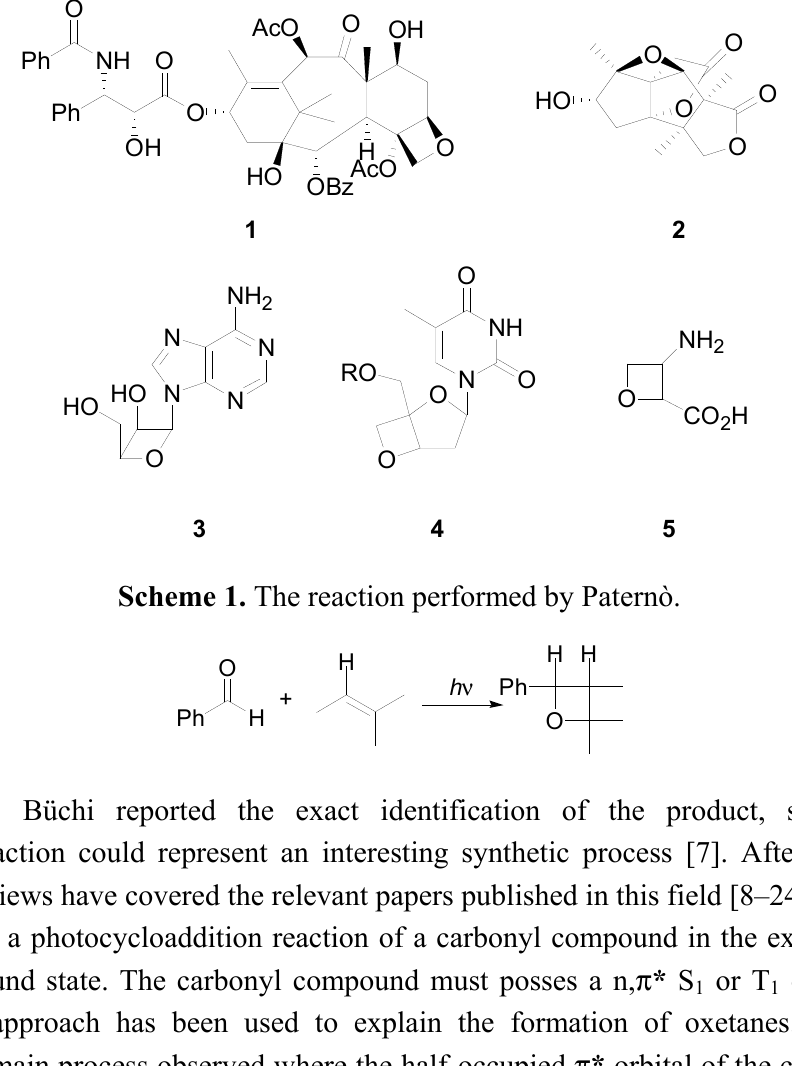
Figure 1. Natural and biologically active compounds containing the oxetane ring.